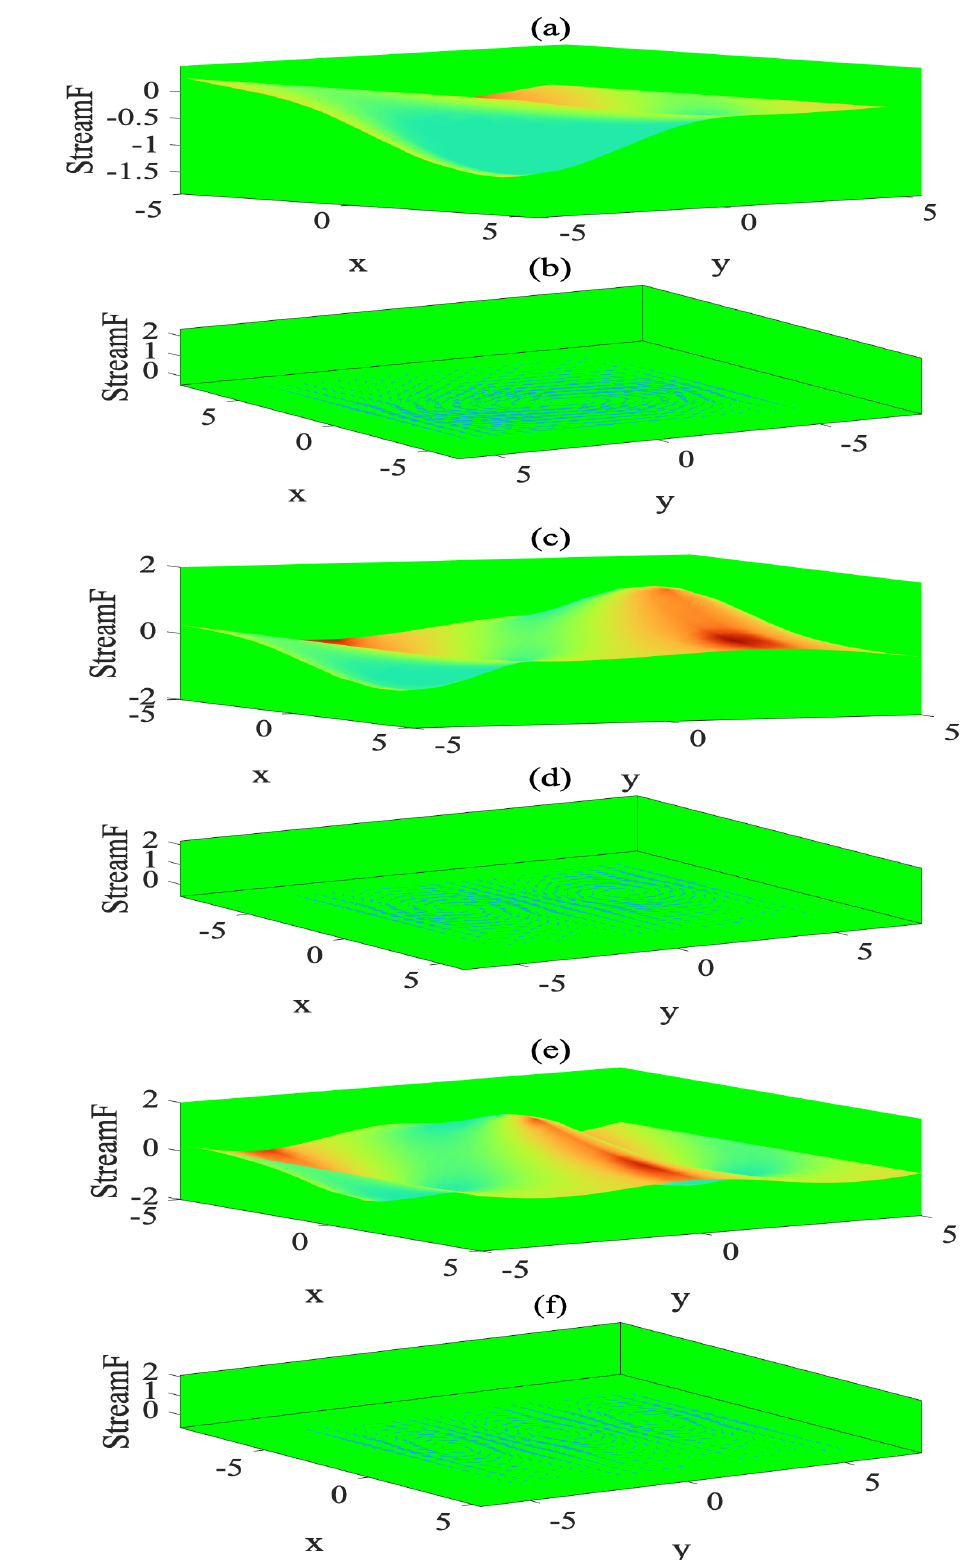
Figure 3. The lump-type vortex monopole ( a , b , with parameter n = 1), vortex dipole ( c , d , with parameter n = 2), and vortex tripole ( e , f , with parameter n = 3), expressed by vortex solution (26) with its other parameters chosen as: (cid:101) = 0.25, c = 0.5, ¯ u = 0.5, α = 2, γ = 2.5, δ = 5, T = 0.25, a 2 = 1, a 1 = 1, a 0 = 5, d = 4, y 1 = − 5 and y 2 =